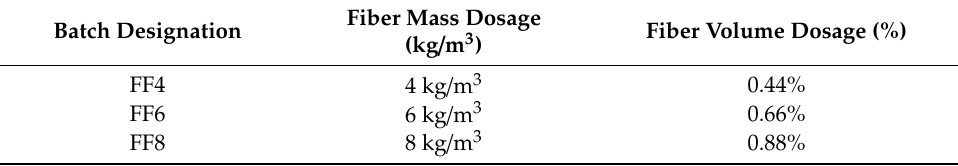
Table 2. Concrete batch identifications.